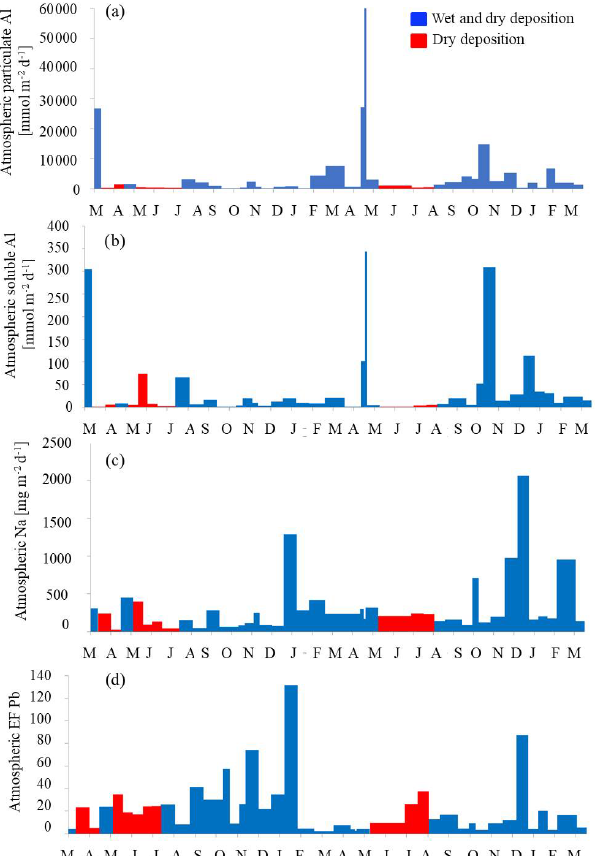
Figure 7. Temporal dynamics of atmospheric particulate alu- minum (a) , soluble aluminum (b) , soluble sodium (c) , and the en- richment factor for lead (d) . The month abbreviation and tick marks correspond to the end of the corresponding month. The width of the bar refers to the length of the sampling